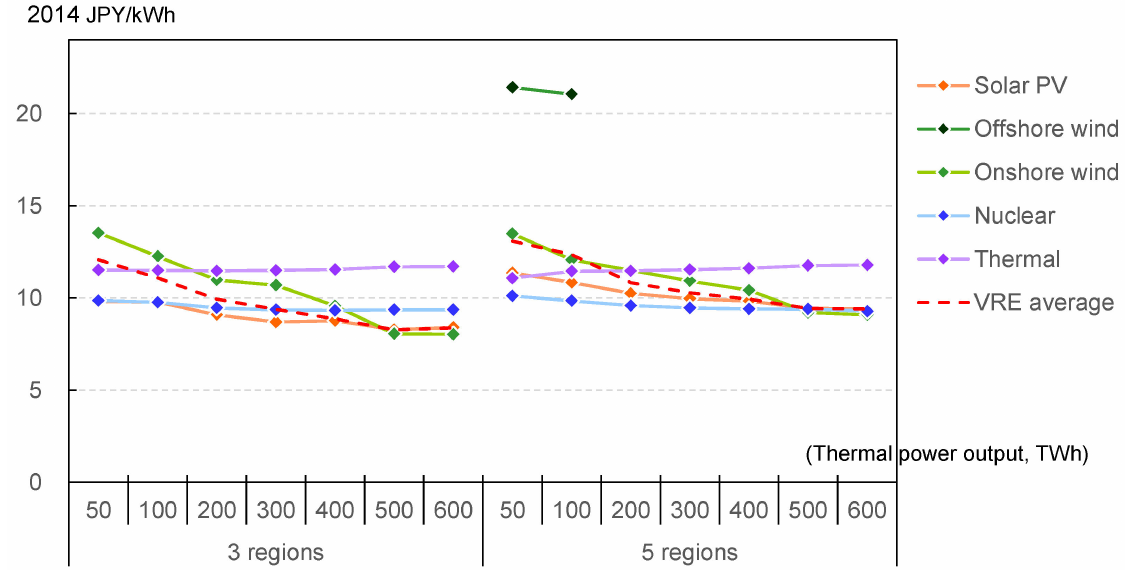
Figure 7. Average system LCOE(Case 7: 2017